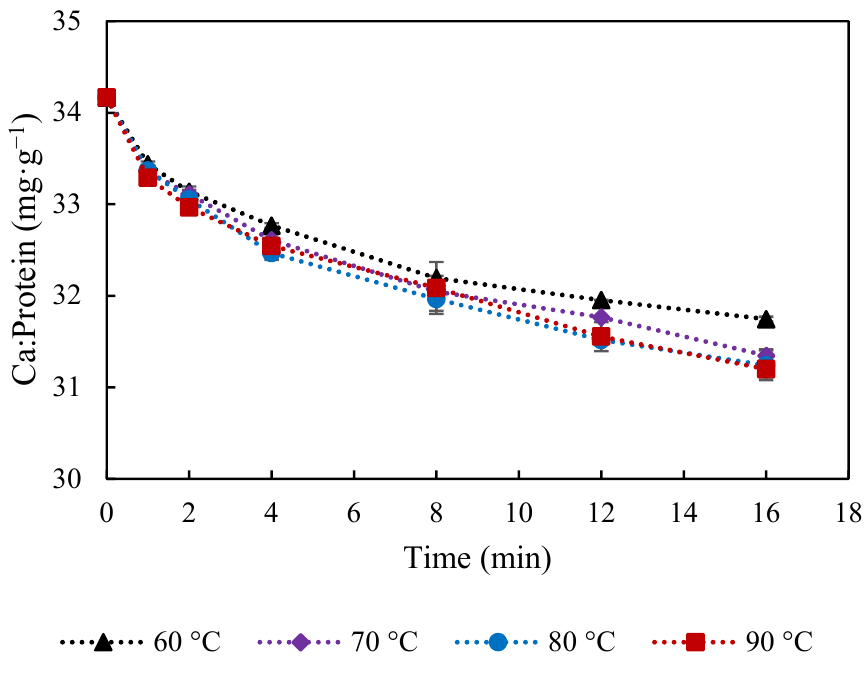
Figure 3. Calcium-to-protein ratio in mg calcium · g − 1 protein at during cooking in water at 60, 70, 80 and 90 °C. The error bars indicate standard deviations.